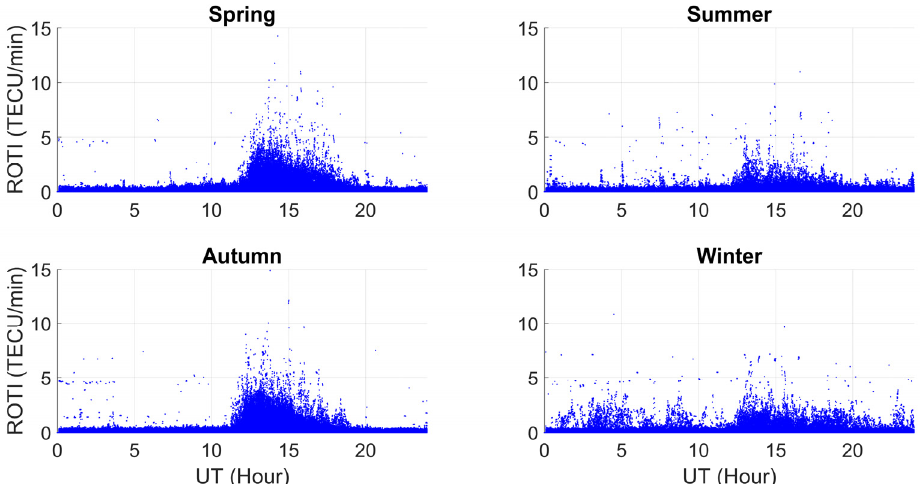
Figure 6. The time series of ROTI (in UT) for all of the observed GPS satellites at the QION site during the four seasons of 2012. The observation periods of each subfigure are as follows: spring: 1 March to 31 May; summer: 1 June to 31 August; autumn: 1 September to 30 November; winter: 1 December to 28 February.